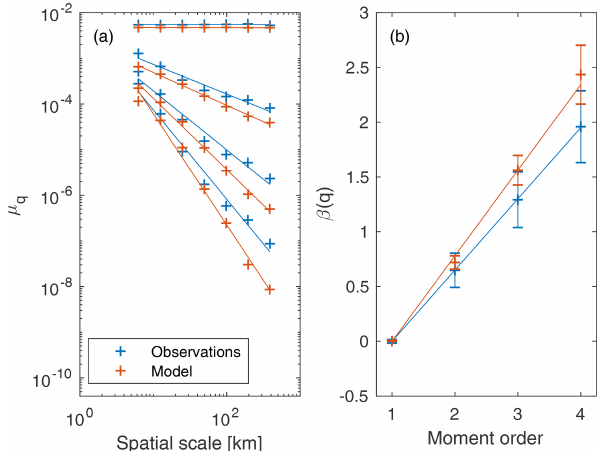
Figure 3. (a) The spatial scaling of observed and simulated lead fraction in the Central Arctic region over JFM 2007. The lines are fits for each moment (order 1, 2, 3, and 4 from top to bottom). (b) The resulting structure function for both observed and simu- lated lead fraction. The lines are linear least-squares fits, and the error bars are the uncertainty in the least-squares fit.